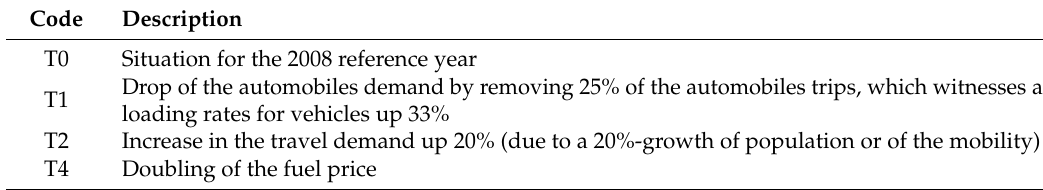
Table 7. Description of the reference situation T0 and of the three studied scenarios (T1, T2 and